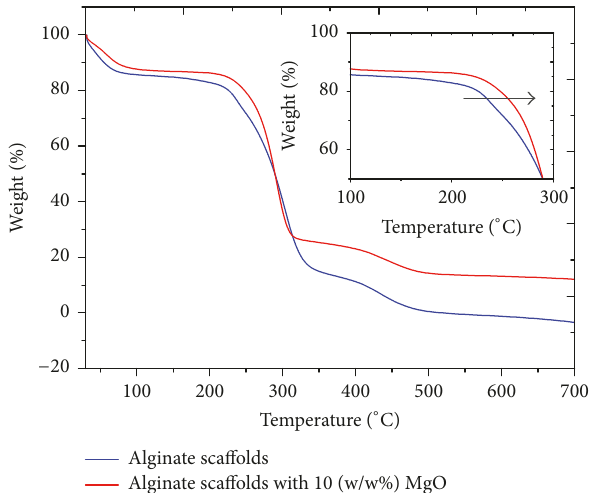
Figure 6: Thermogravimetric curves of electrospun alginate and alginate/MgO